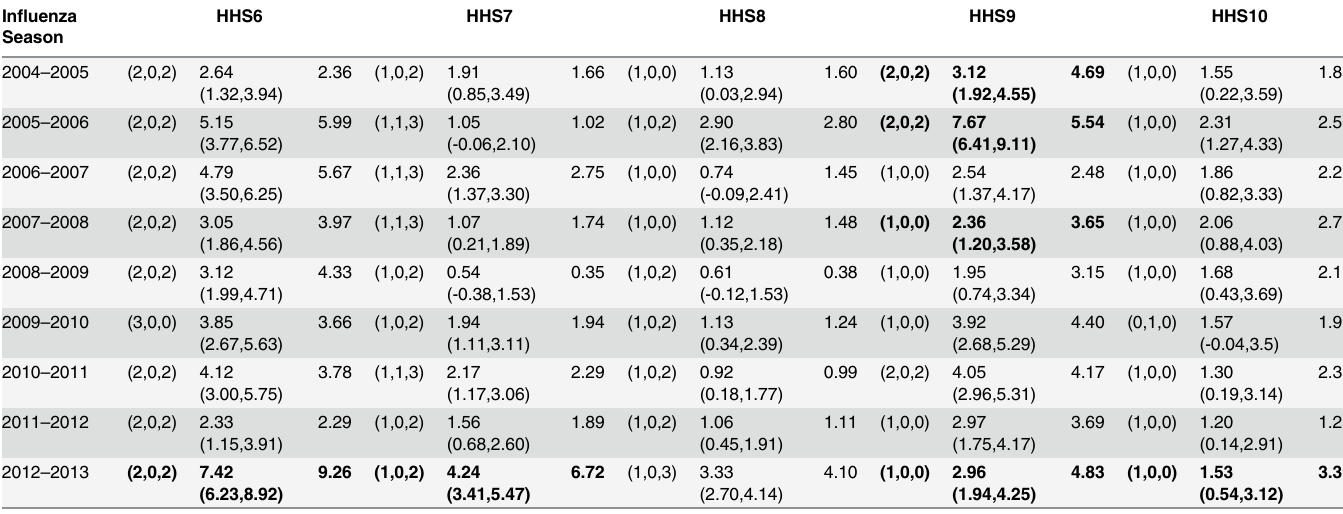
Table 2. Last Week ILI rate prediction for HHS regions 6 – 10 from influenza seasons 2004 – 2005 to 2012 –